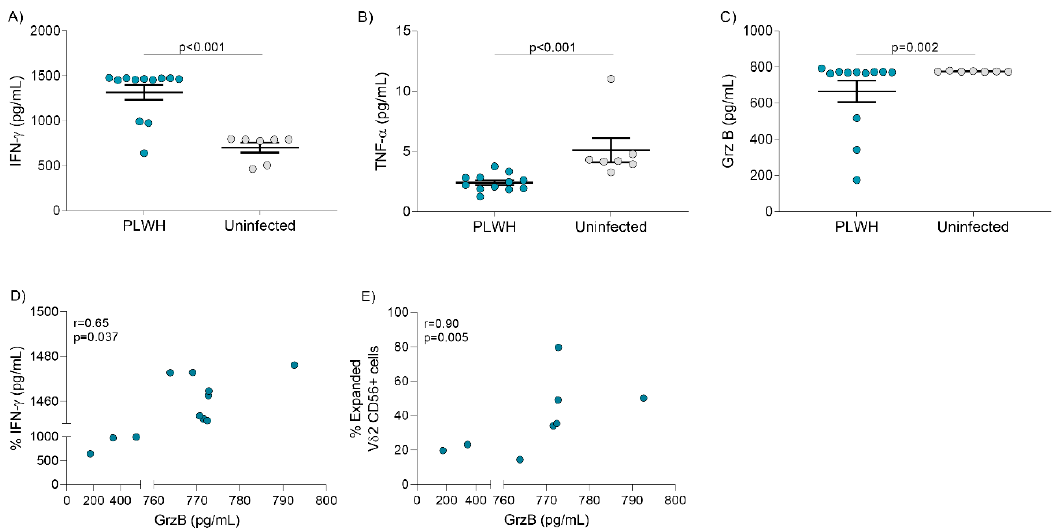
Figure 4. Cytokine release after seven days of expansion with PAM and IL-2. Quantification of cytokine levels was performed in supernatants from seven-day expansion cultures. Production of ( A ) IFN- γ ( B ) TNF- α and ( C ) GrzB in PLWH (N = 12) compared to uninfected donors (N = 7) (Mann-Whitney